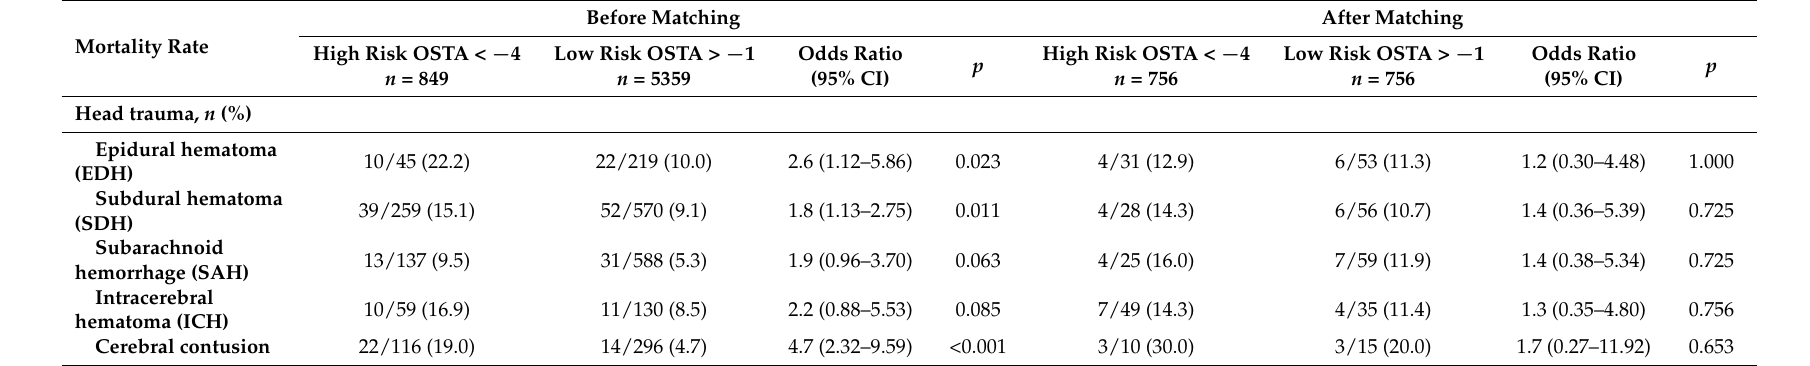
Table 5. Mortality rate of different types of trauma injury to the brain in high-risk vs. low-risk patients.